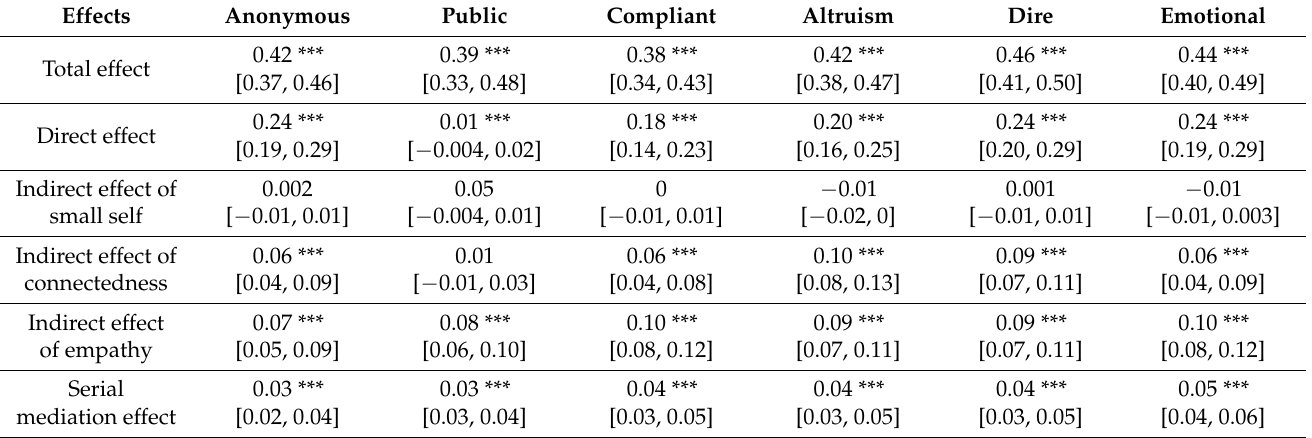
Table 3. Effect decomposition and interval estimation of each dimension of prosocial tendencies predicted by dispositional